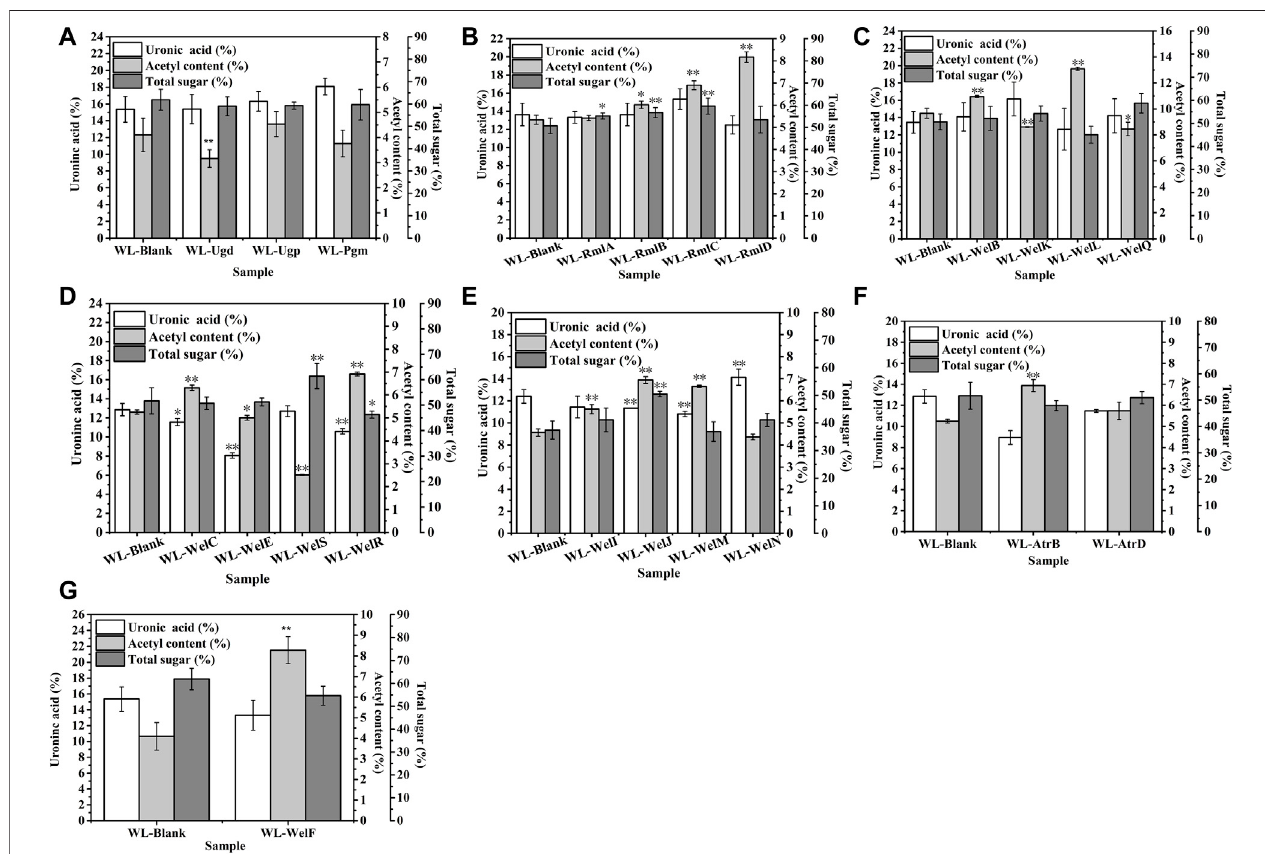
FIGURE 6 | The effects of gene over-expression on the chemical composition of EPS. (A) The effects of genes in nucleotide-sugar UDP-glucose and UDP- glucuronic acid biosynthesis. (B) The effects of genes in nucleotide-sugar TDP-Rhamnose biosynthesis. (C) The effects of genes in repeating unit assembly. (D) The effectsof genes in the polymerization process. (E) The effects ofgenes in exporting process. (F) The effects of ABC transporter protein AtrB and AtrD. (G) The effectsof welF on the chemical composition of EPS.